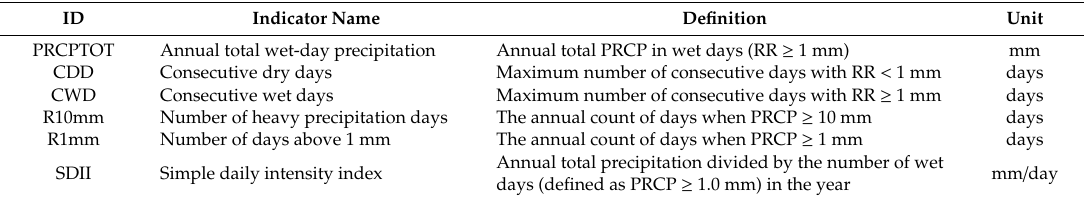
Table 4. List of the ETCCDI extreme climate